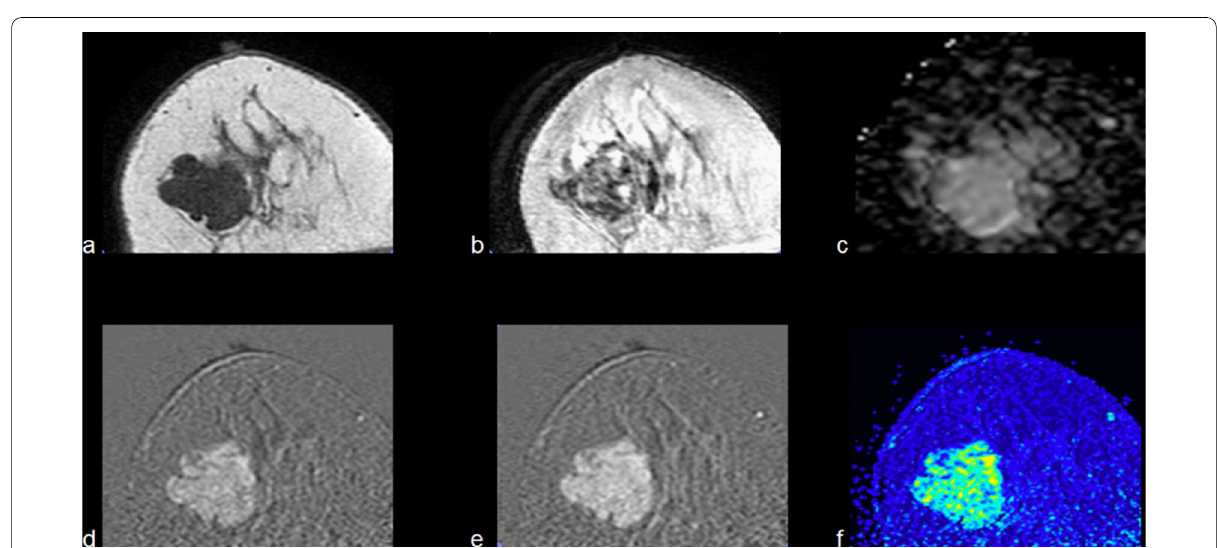
Fig. 6 Example of MRI finding of breast lesion classified as BIRADS 4A by echography. A 63‑years‑old patient presents a solid lobulated mass, hypointense on T1W ( a ) with no diffusivity restriction ( c ), which shows a periphery with cystic content on T2W ( b ). The contrast uptake shows an ascending and plateau curve from the initial ( d ) to delayed ( e ) subtractions, with a homogeneous gradual wash‑in ( f ). Those features indicate benignity (Kaiser score 2); however, it was classified as BIRADS 4 at MRI due to mass size increase. The pathological analysis confirmed it as a